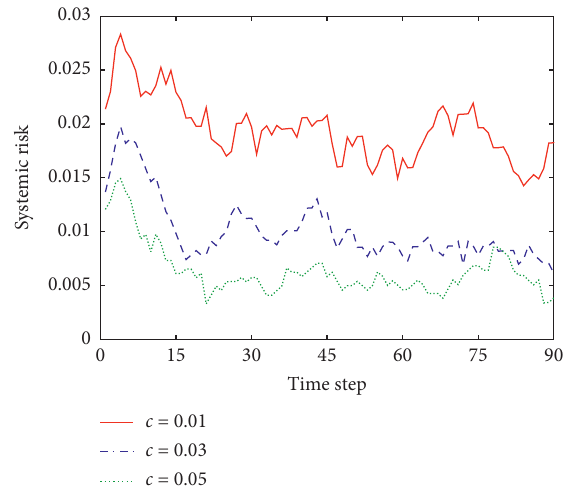
Figure 6: The impact of changes in credit connection between shadow banks and commercial banks on systemic risk curves (the parameter setting is the same as in Figure 3 except M � 100, N � 300, and c ).